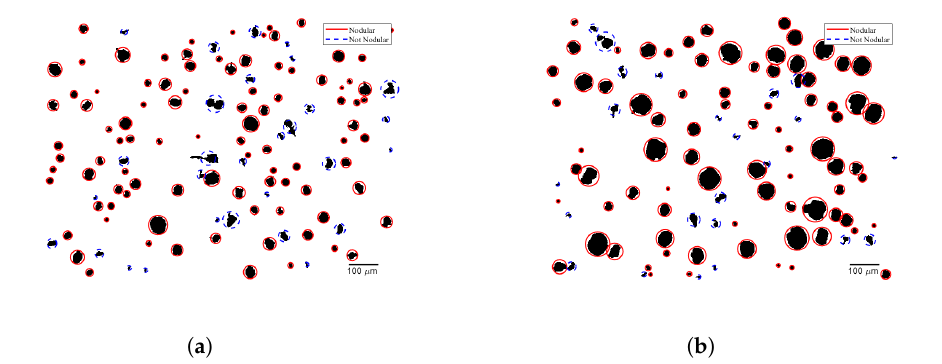
Figure 20. Computational image identification on GGG70. ( a ) GGG70-1. ( b ) GGG70-2.